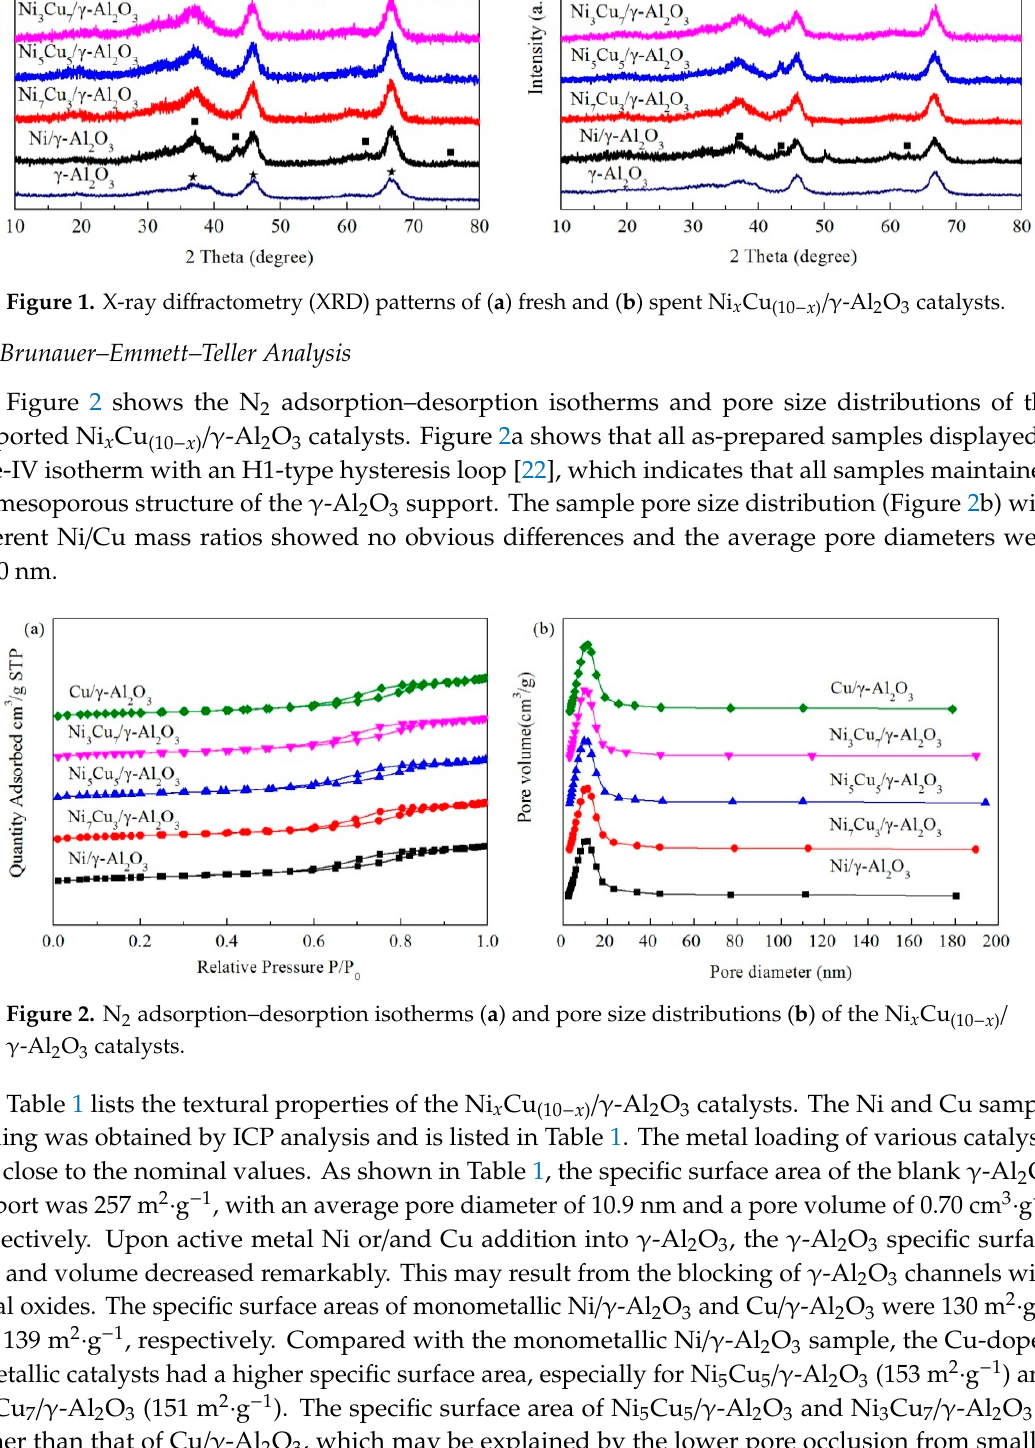
Figure 2. N 2 adsorption–desorption isotherms ( a ) and pore size distributions ( b ) of the Ni x Cu (10- x ) / γ -Al 2 O 3 catalysts.